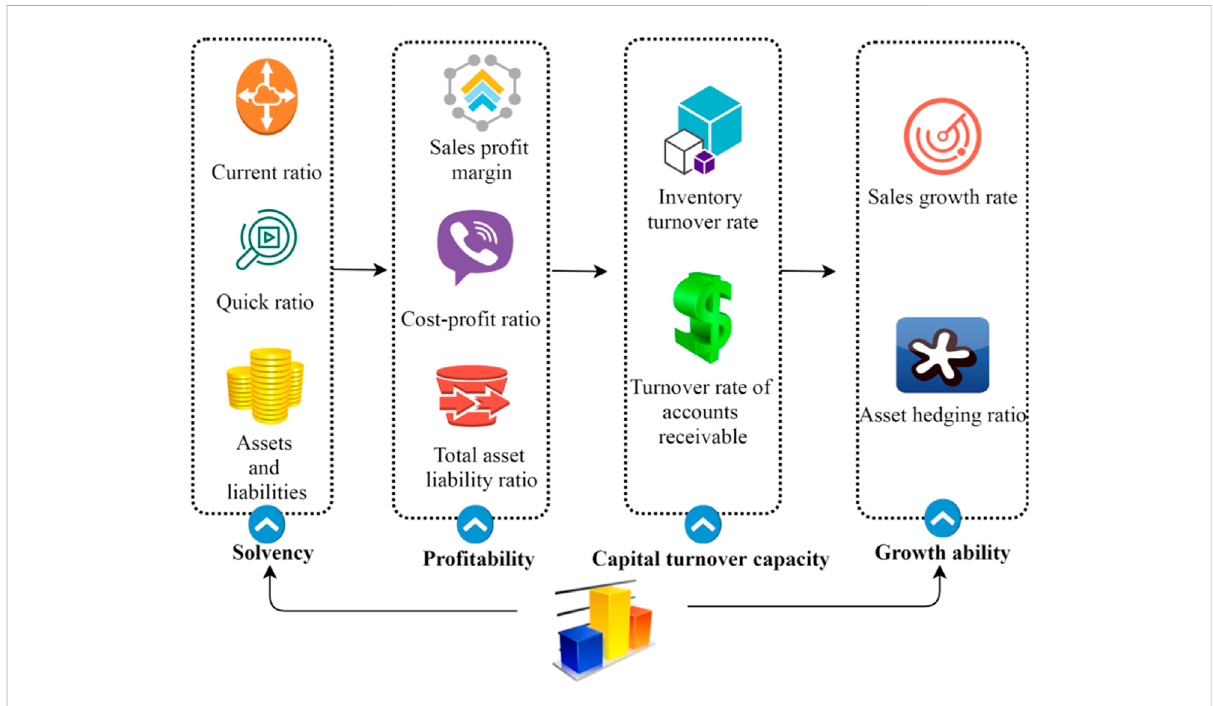
FIGURE 2 Financial risk early warning indicator